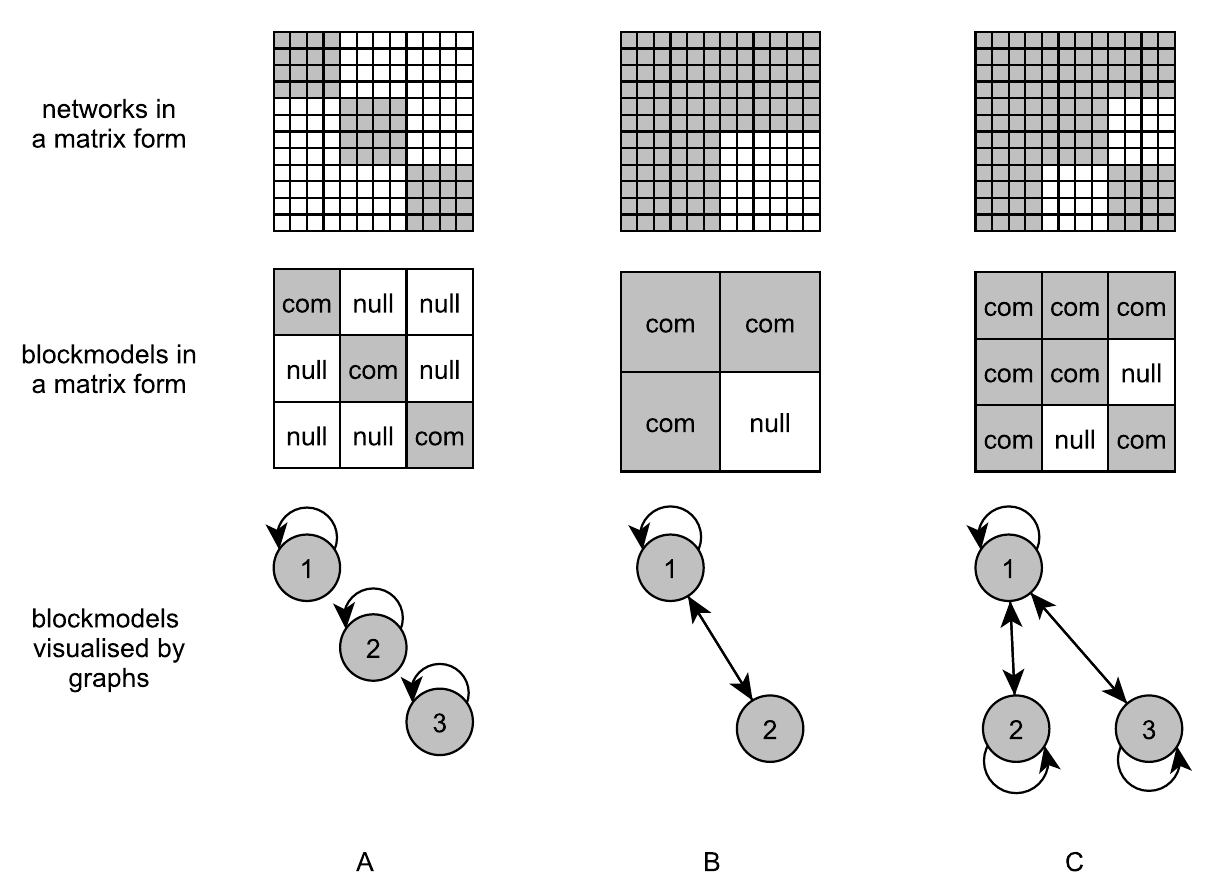
Fig 2. Different representations of networks with a cohesive blockmodel, symmetric core-periphery blockmodel, and symmetric core-cohesive blockmodel. (A) cohesive blockmodel, (B) symmetric core-periphery blockmodel, (C) symmetric core-cohesive blockmodel.